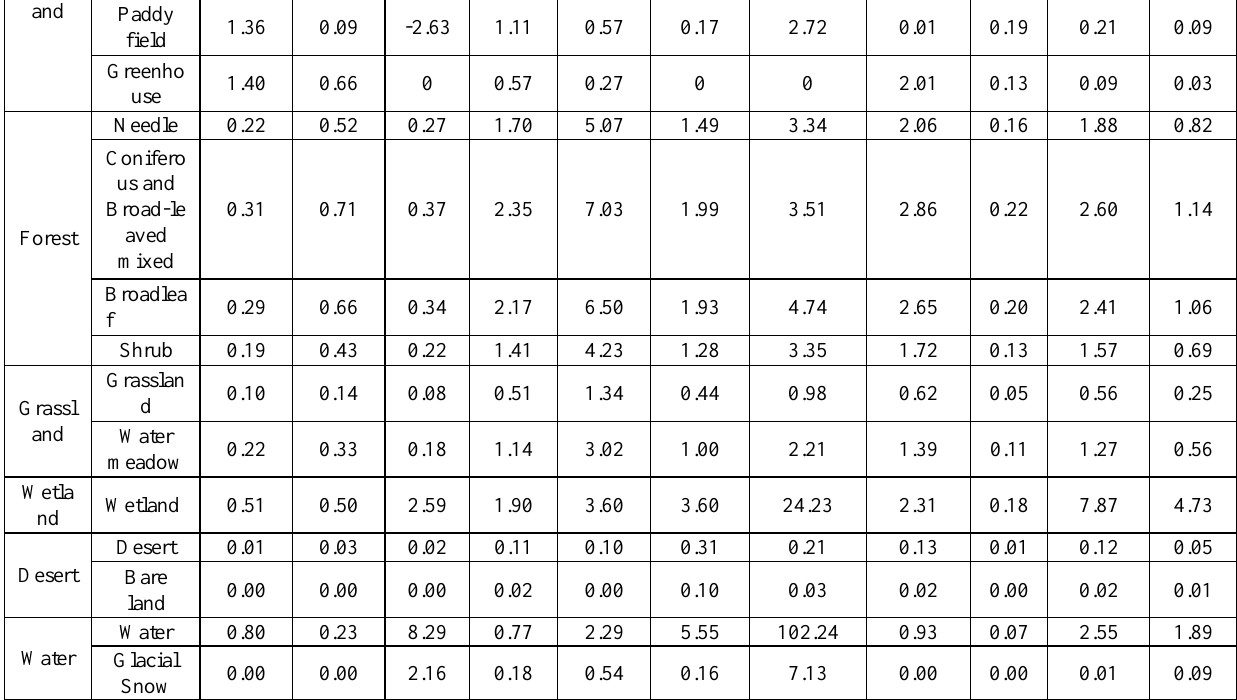
Table 1. The equivalents of ESV supplied by per unit area of ecosystem